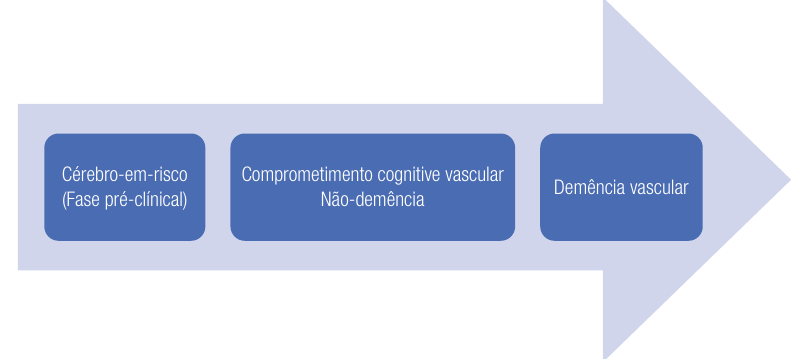
Figura 2. O espectro do comprometimento cognitivo